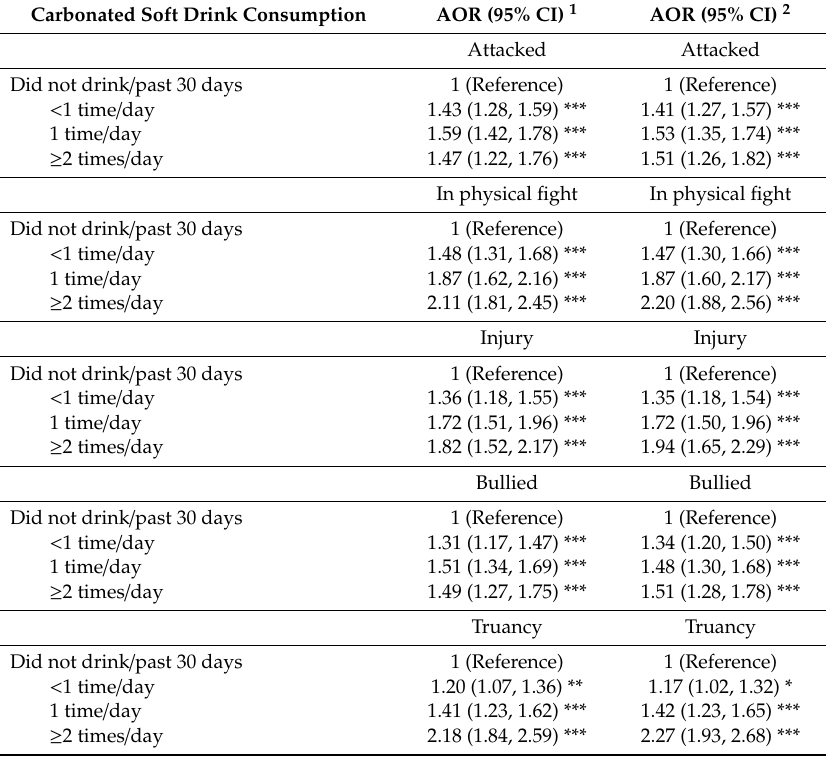
Table 3. Associations between soft drink use frequency and being attacked, in a physical fight, injury, being bullied, and